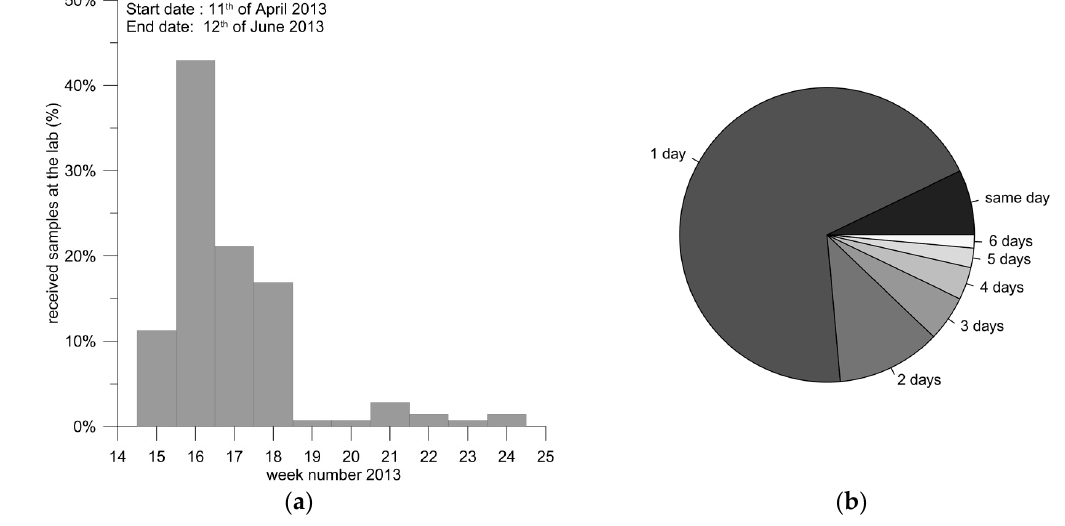
Figure 2. ( a ) Timing of samples received at the laboratory (%) indicating that the largest part of the sampling was conducted between weeks 15 and 18 (week 14 in 2013 started on 1 April); ( b ) Shipping periods: proportion of samples received at the lab on the same day of sampling or 1–6 days later.